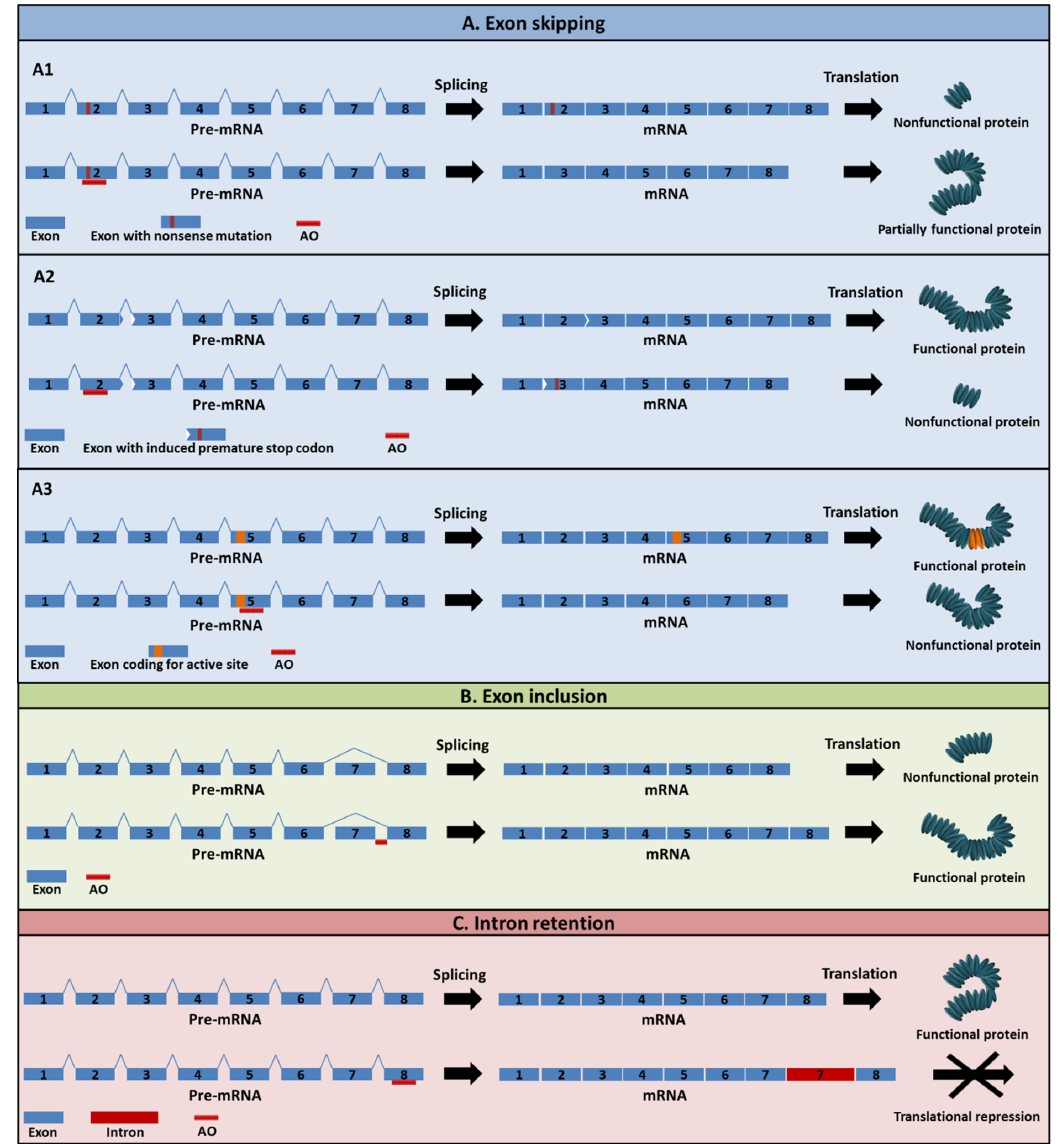
Figure 3. Representation of AO-mediated splice modulation, including ( A ) exon skipping, ( B ) exon inclusion, and ( C ) intron retention. Specially, exon skipping can be used to ( A1 ) remove nonsense mutation to restore essential protein expression, or ( A2 ) induce a premature stop codon or ( A3 ) remove an exon-encoding active site to downregulate the expression of an unwanted protein. Exon inclusion can be used to increase the production of an essential protein, while intron retention may be used to reduce the expression of an unwanted protein by inducing translational repression.